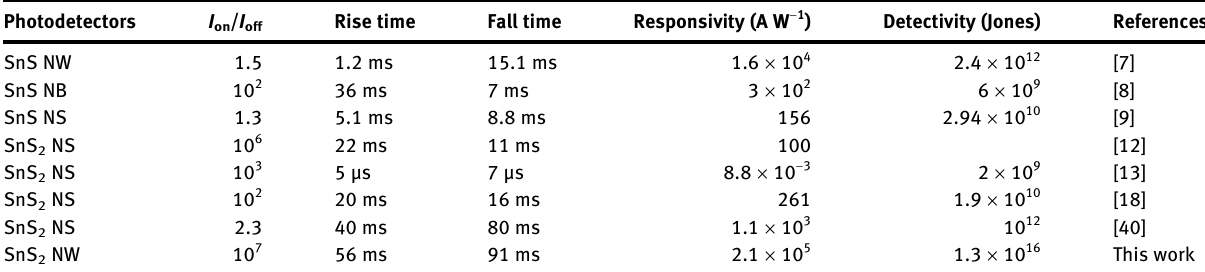
Table  : Comparison of the critical parameters for tin sul fi des SnS and SnS  nanostructure photodetectors.